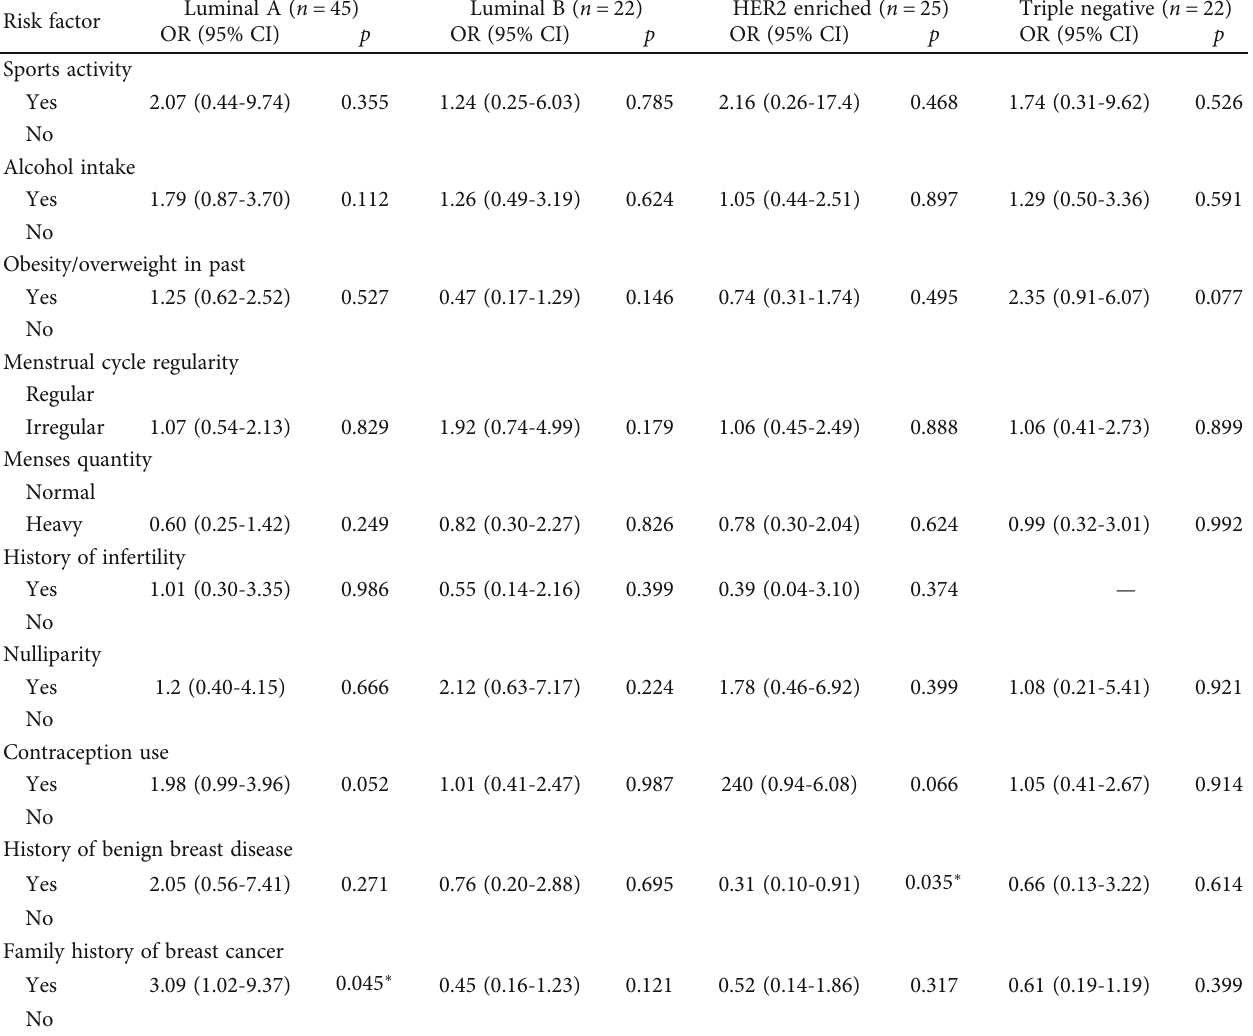
Table 4: Associations between risk factors and molecular subtypes.